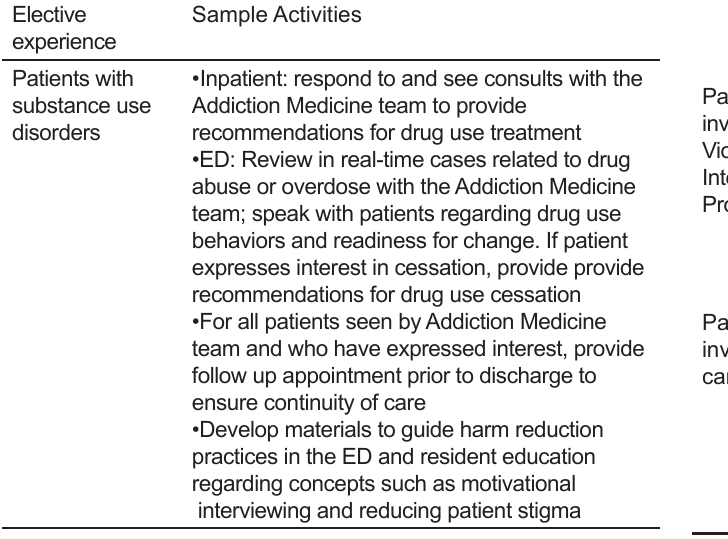
Table 1. Description of Social Medicine Elective Experiences